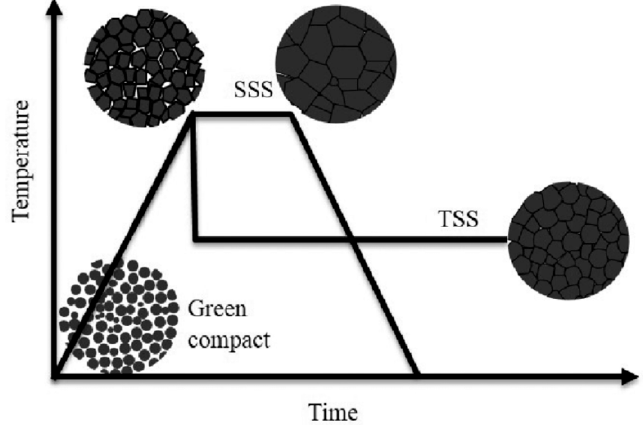
Figure 13. Schematic of densification of ceramics with grain growth during conventional single-step sintering (SSS) and densification without grain growth at lower second-step temperature during TSS with higher first-step temperature. © 2017 Sutharsini U, Thanihaichelvan M, Singh R. Published in Ref. [175] under CC BY 3.0 license. Available from: https://doi.org/10.5772/68083.